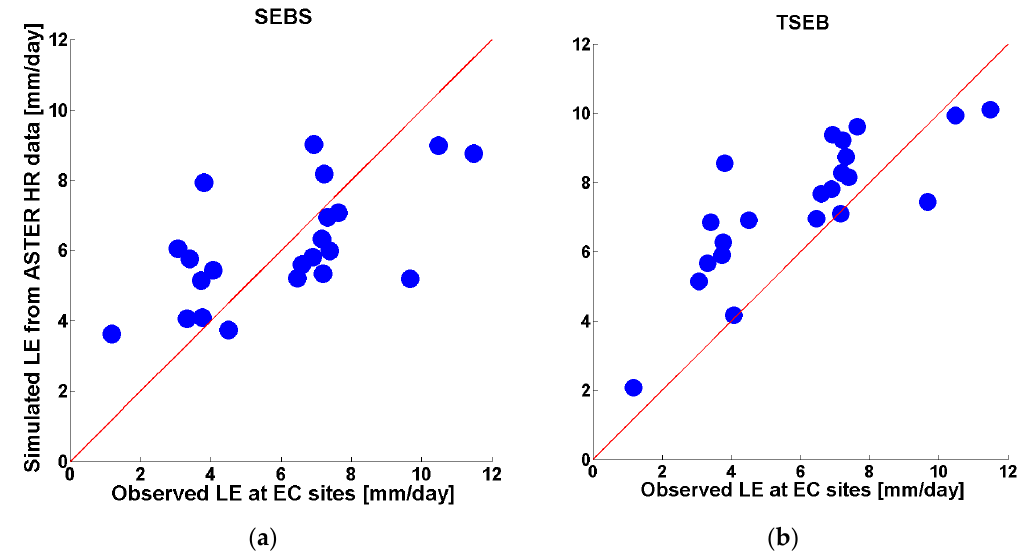
Figure 4. Validation of SEBS ( a ) and TSEB ( b ) HR latent heat fluxes obtained using our simple approach to derive crop heights.